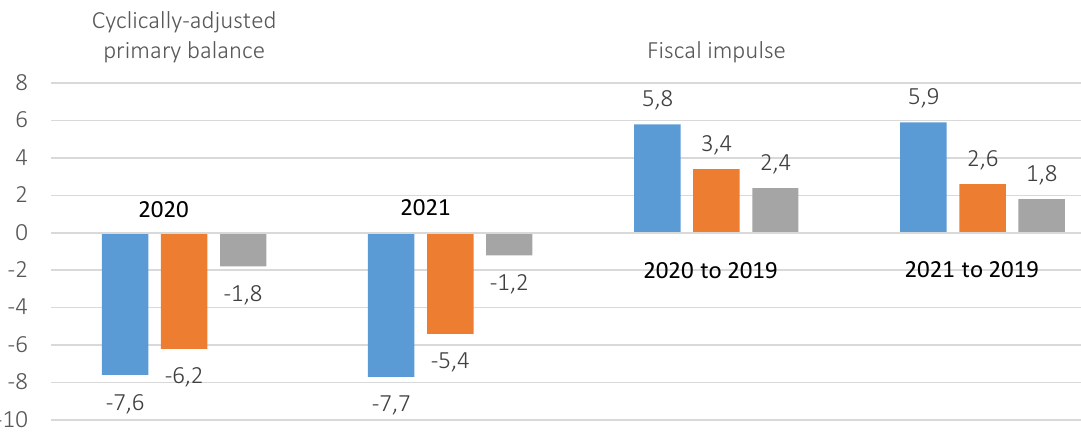
Figure 2. Cyclically-adjusted primary balances (CAPBs) and fiscal impulses in Ukraine and country groups as a % of the